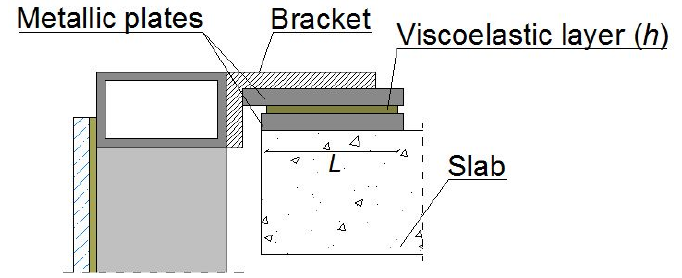
Figure 4. Working scheme of a possible viscoelastic